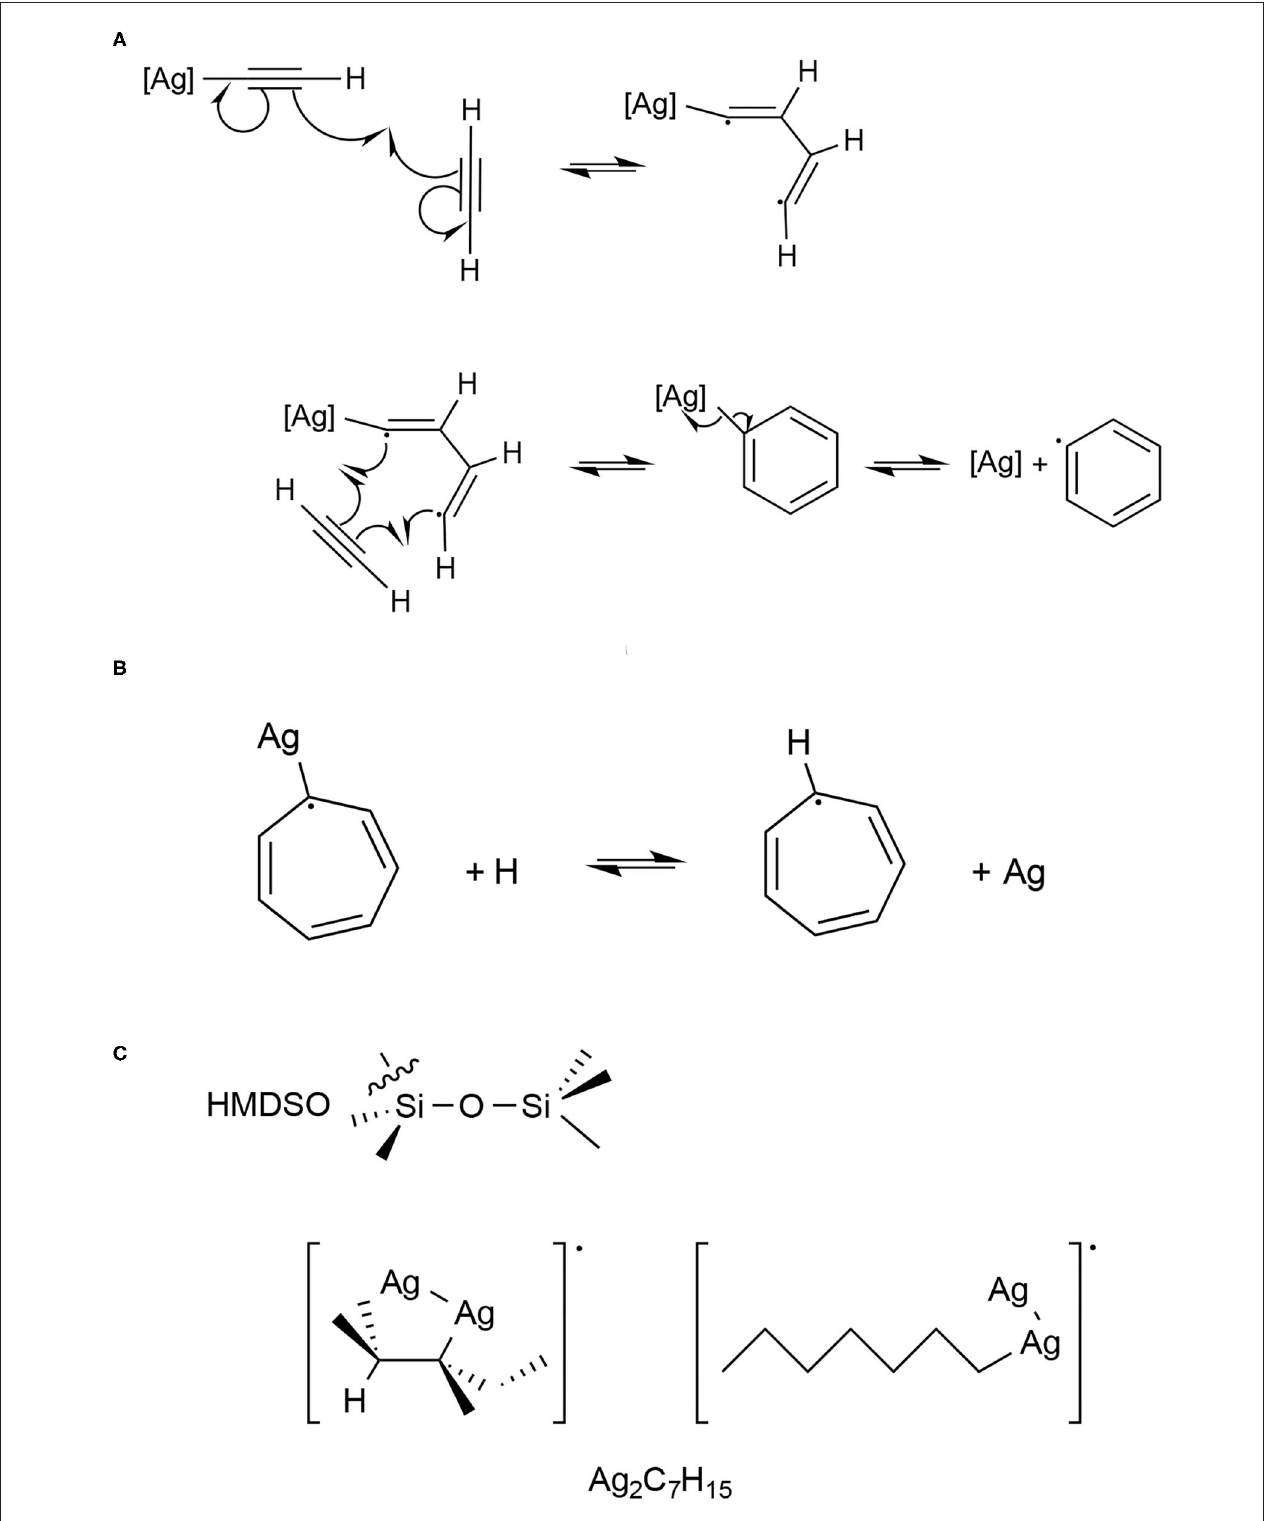
FIGURE 9 | (A) Possible initial steps of the radical mechanism for C-C coupling on a metallic cluster [Ag] with formation of the first aromatic ring [C 6 H 5 ] • ; (B) Substitution of Ag by H to form [C 7 H 7 ] • (C) Examples of possible isomers for [Ag 2 -C 7 H 15 ] • . In (A–C) only the H atoms of interest are represented. Let us specify that neutral species are shown here, whereas cationic species are detected by